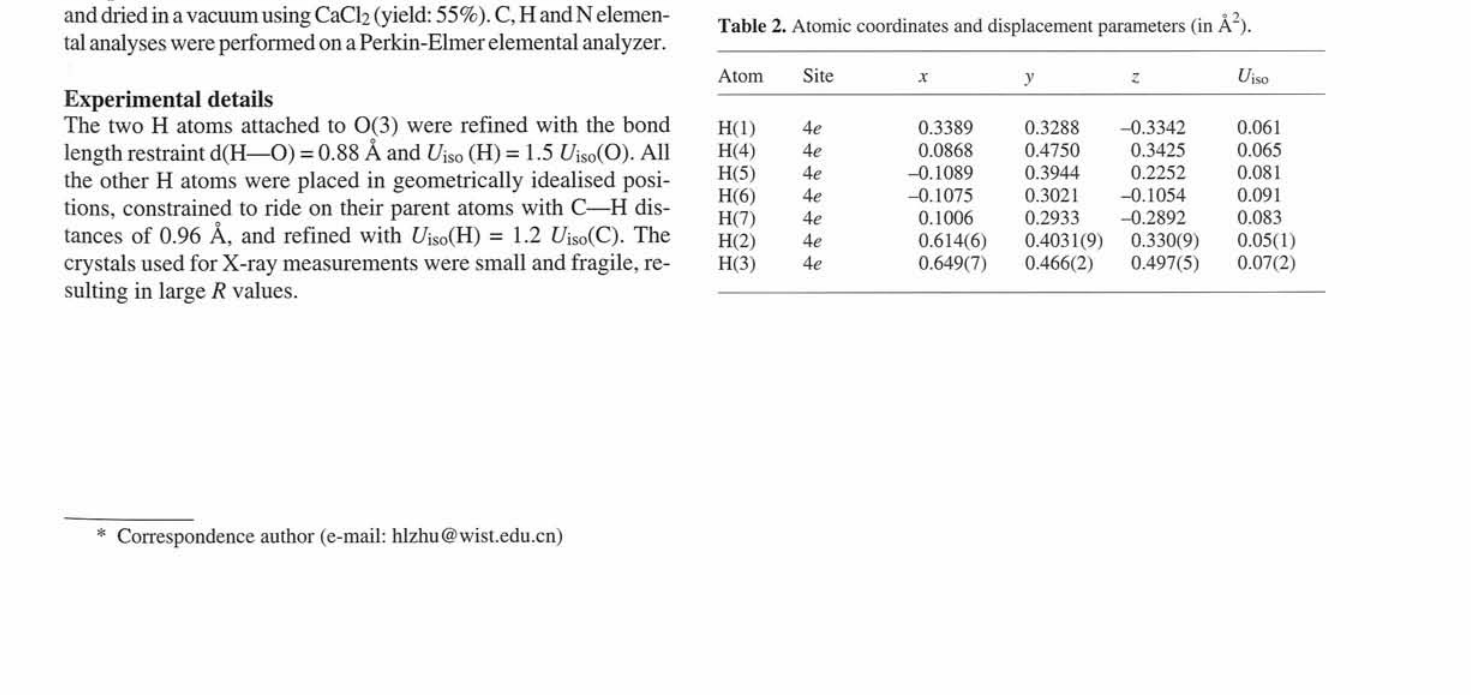
Table 2. Atomic coordinates and displacement parameters (in Â 2